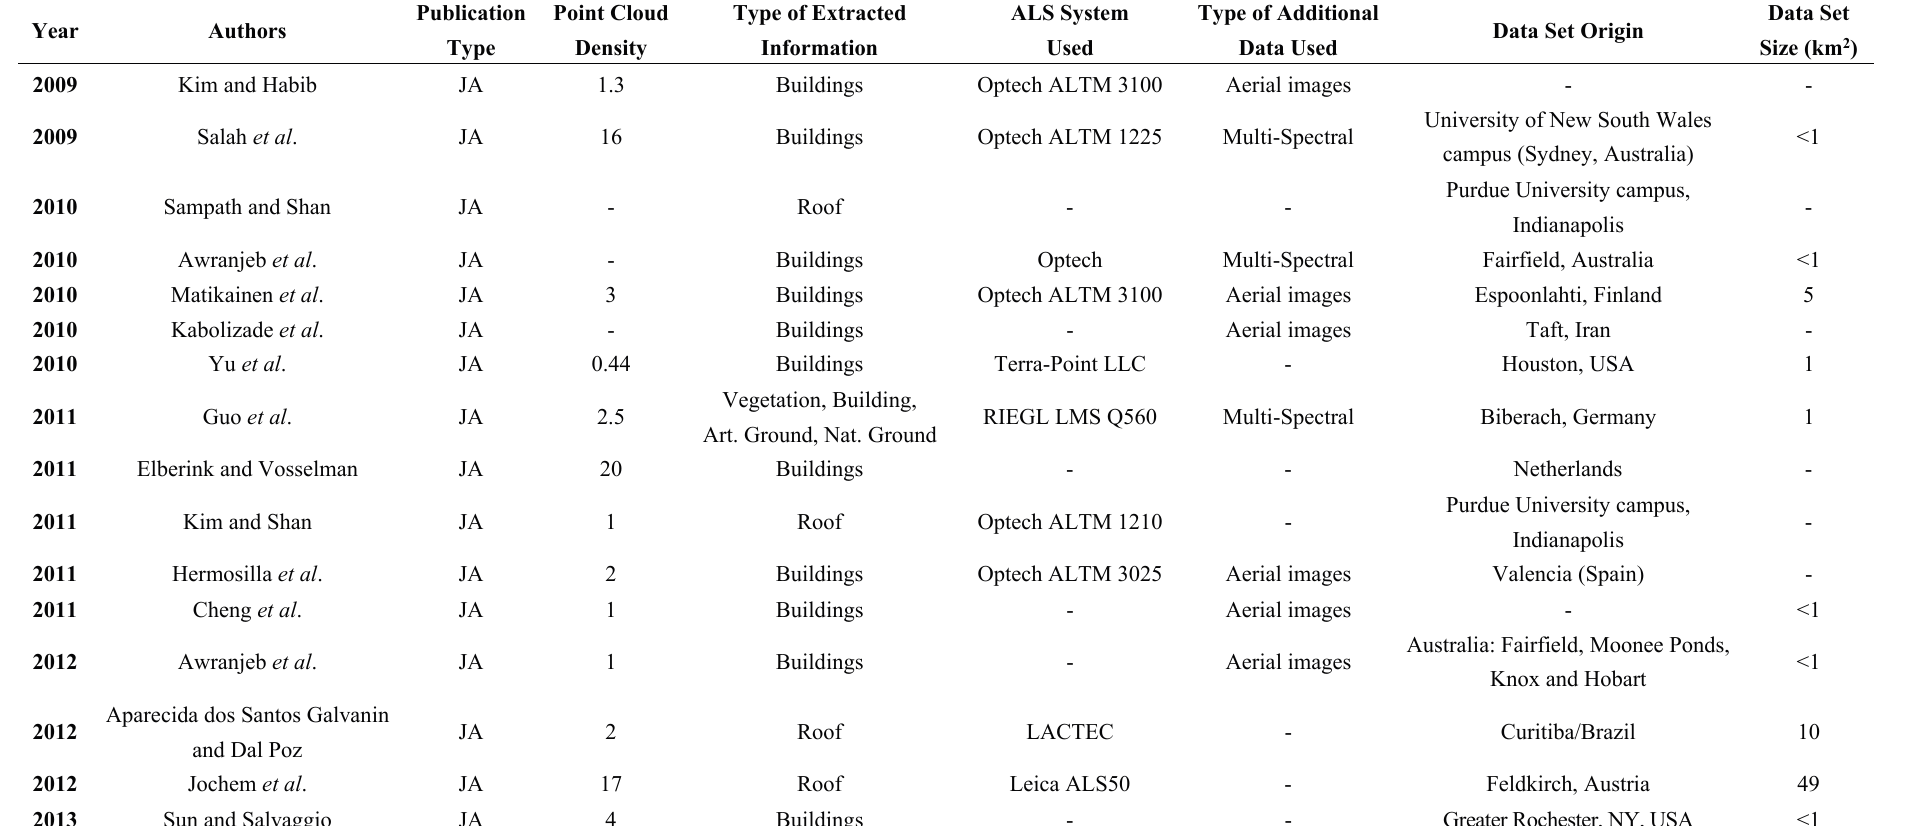
Table 3. List of the selected 54 ISI-indexed and 14 non ISI-indexed publications (Year: Year when the publication was published; Authors: The name/names of the author/authors; Type: Type of publication—JA (Journal Article) or CP (Conference Proceeding); Density: Density of the point cloud as reported by the author. In the case of several data sets an average value is used; Type of classes: Shows classes extracted by the described approach; ALS System: Name of the ALS system used to perform recording (if available); Additional data: Description of additional data source that was used to perform analysis; Test area: Geographic region which represents the data set, used to provide the insight into the variability of morphological features of used data sets; Area size: Size of the data set in square